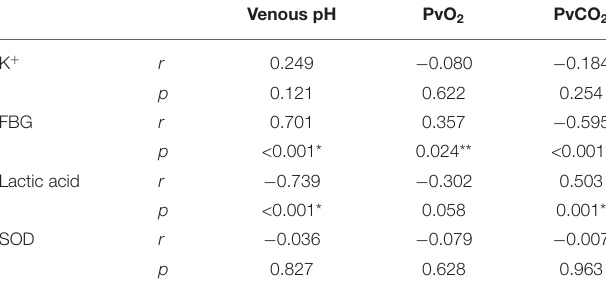
TABLE 7 | Correlation analysis of venous pH, PvO 2 , PvCO 2 , and other effect indicators in the control group. Venous